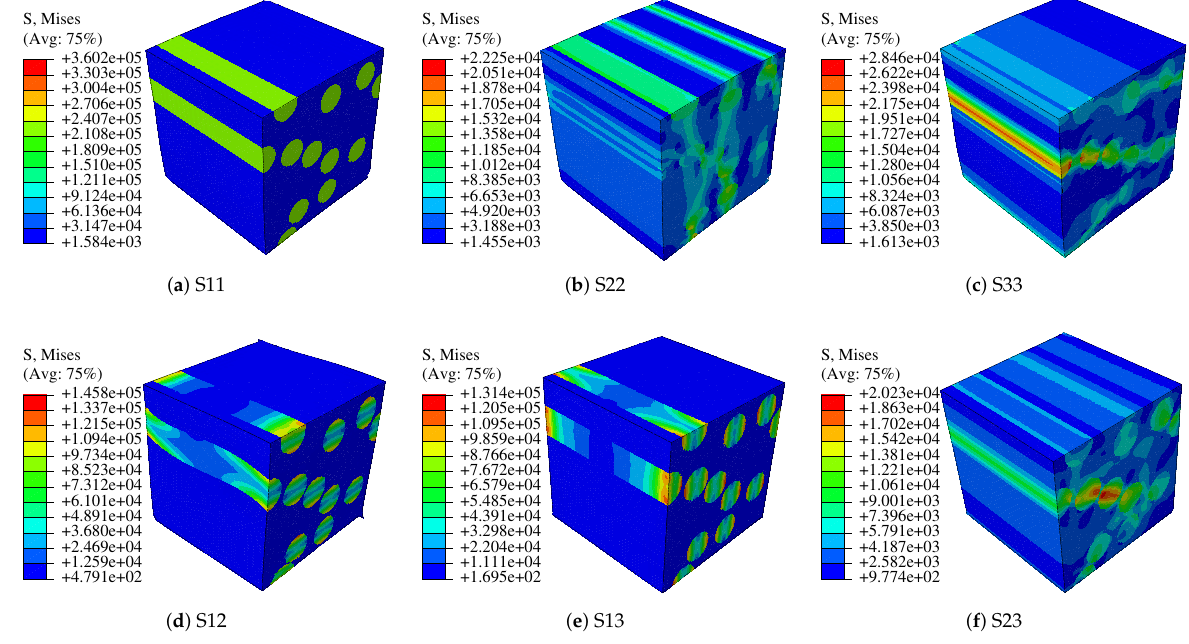
Figure 6. Characteristic stress distribution in each direction